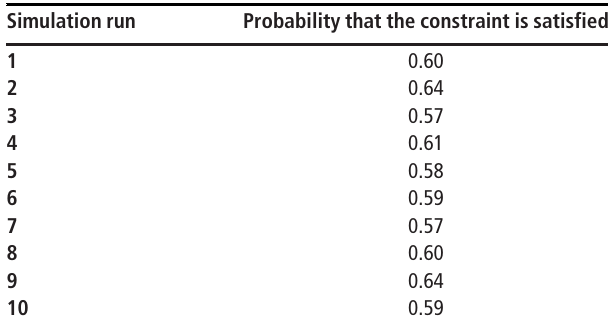
Table 8 Applicability of the optimal solution of model 1 for